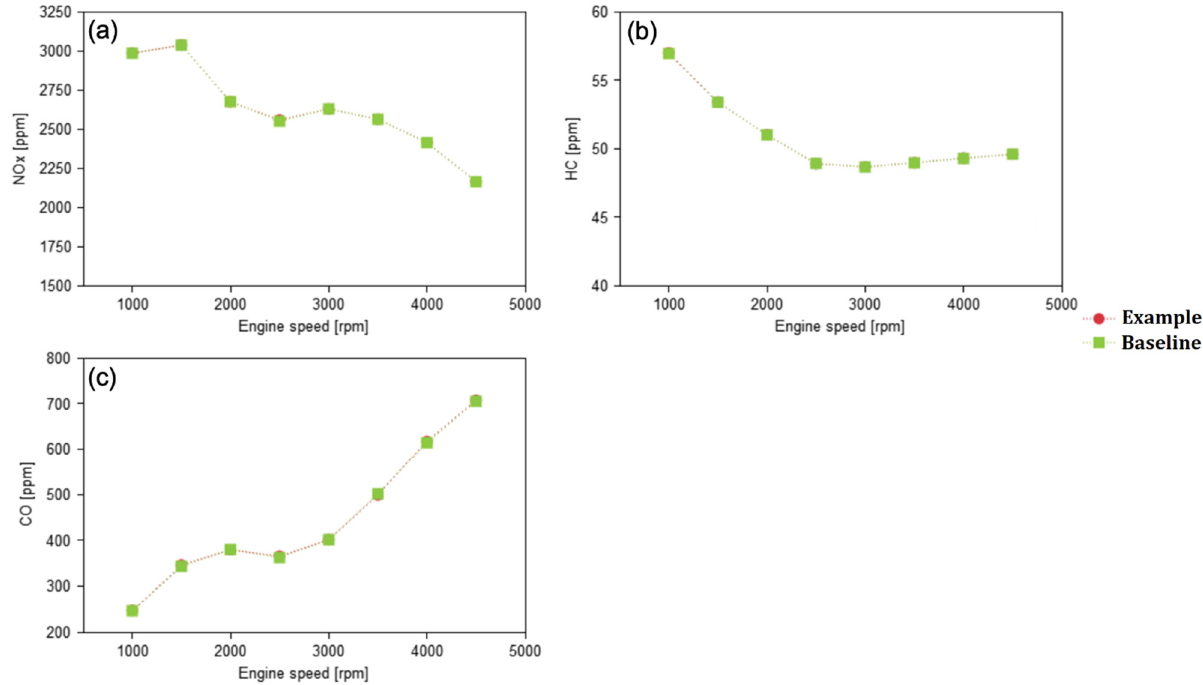
Figure 4. Model validation—comparison of emissions ( a ) NO x , ( b ) HC , and ( c ) CO , and between WAVE example model and baseline model.